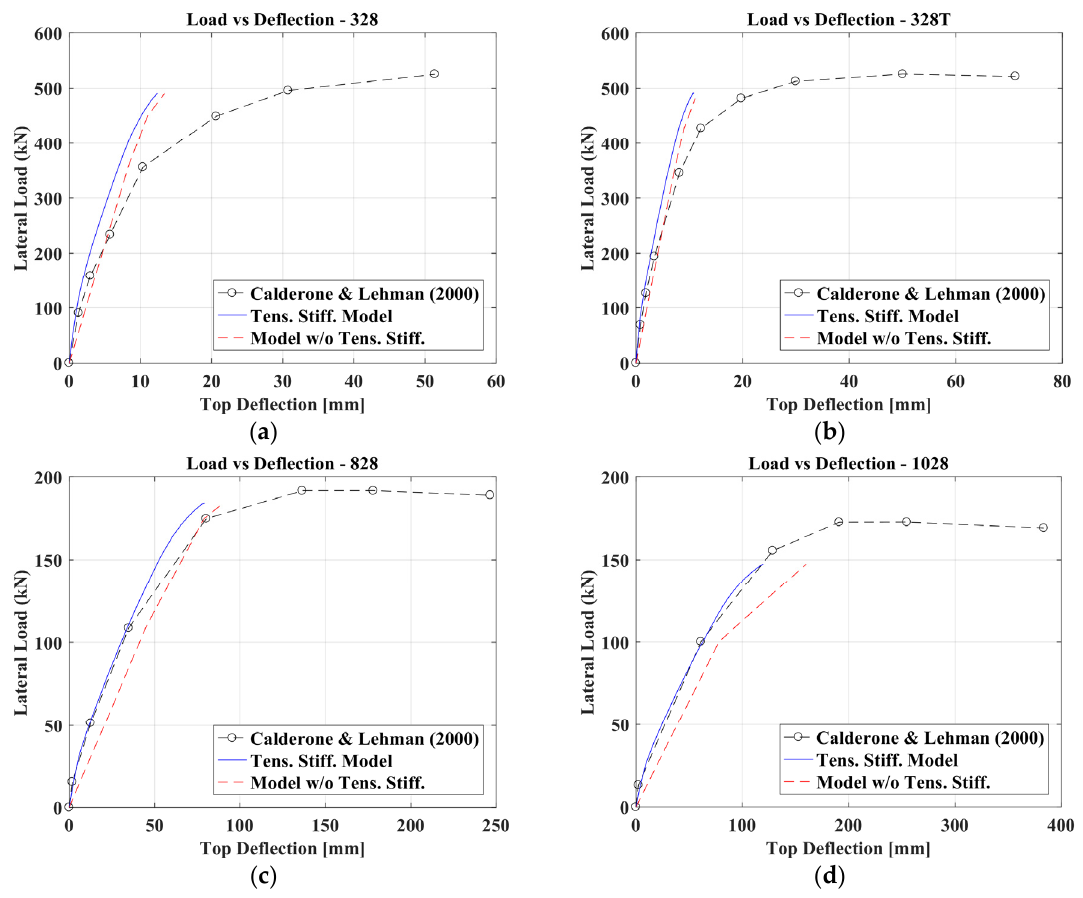
Figure 12. Comparison between the experimental results of Calderone and Lehman [27] and the numerical ones in terms of initial stiffness: Column IDs ( a ) 328, ( b ) 328T, ( c ) 828 and ( d ) 1028